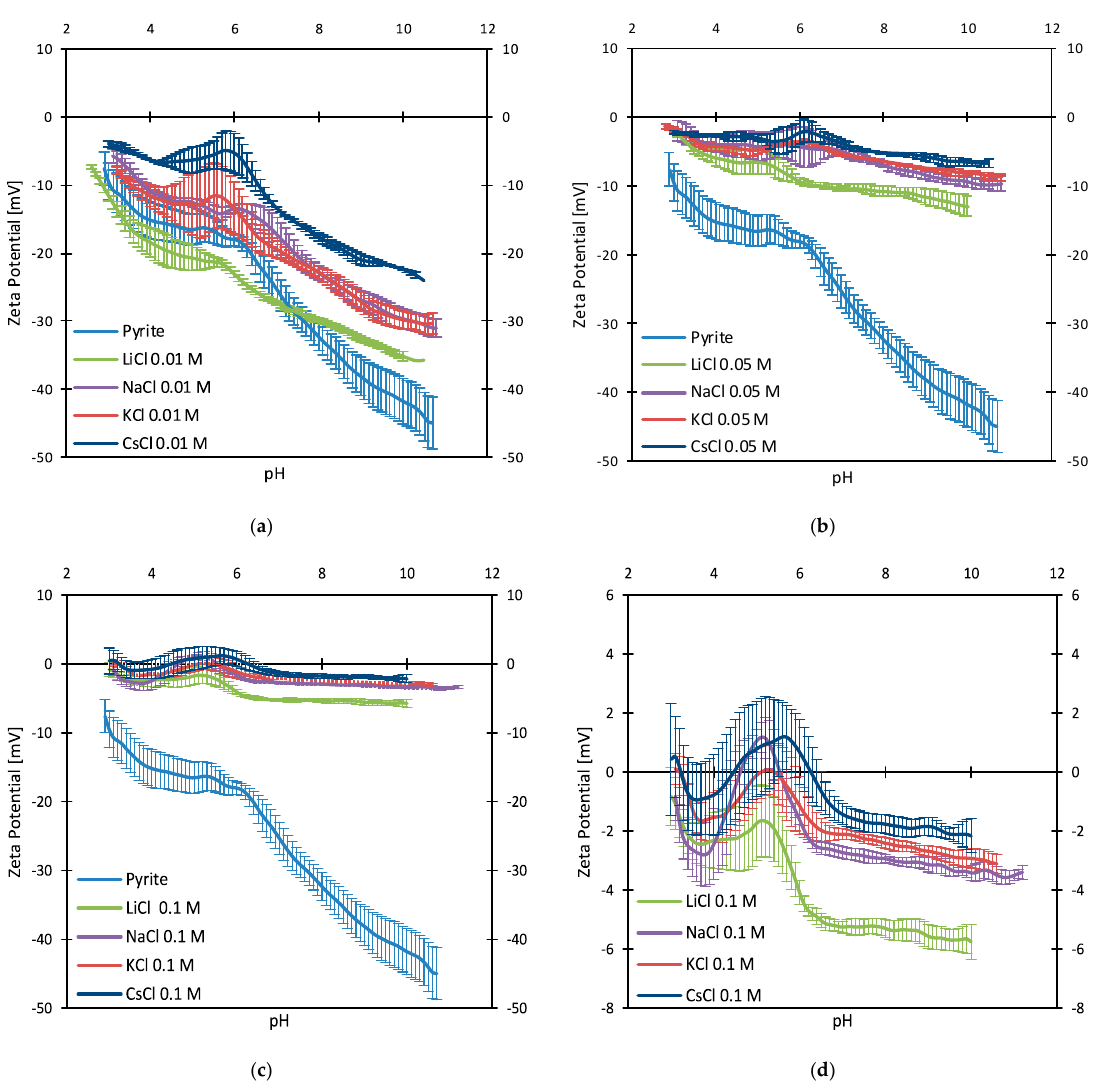
Figure 3. Zeta potential of pyrite as function of pH for different chloride salts of the monovalent alkaline metal series, comparison at concentrations ( a ) 0.01 M, ( b ) 0.05 M, ( c ) 0.1 M. Frame ( d ) is an enlarged view of Frame (c) to better distinguish the curves at the higher pH. Error bars are omitted for clarity but are available in Figure 1. Label Pyrite is omitted in curves for salts.